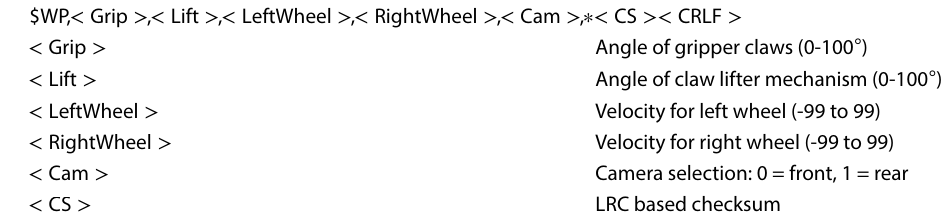
Table 4 Communications packet structure PC to